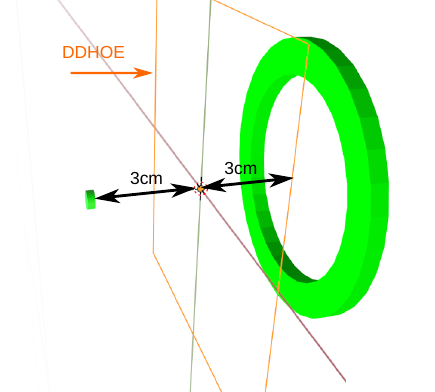
Figure 7. To test the alignment of the projected scene with the real-world, we placed a 3D printed object, 3 cm behind the DDHOE display.